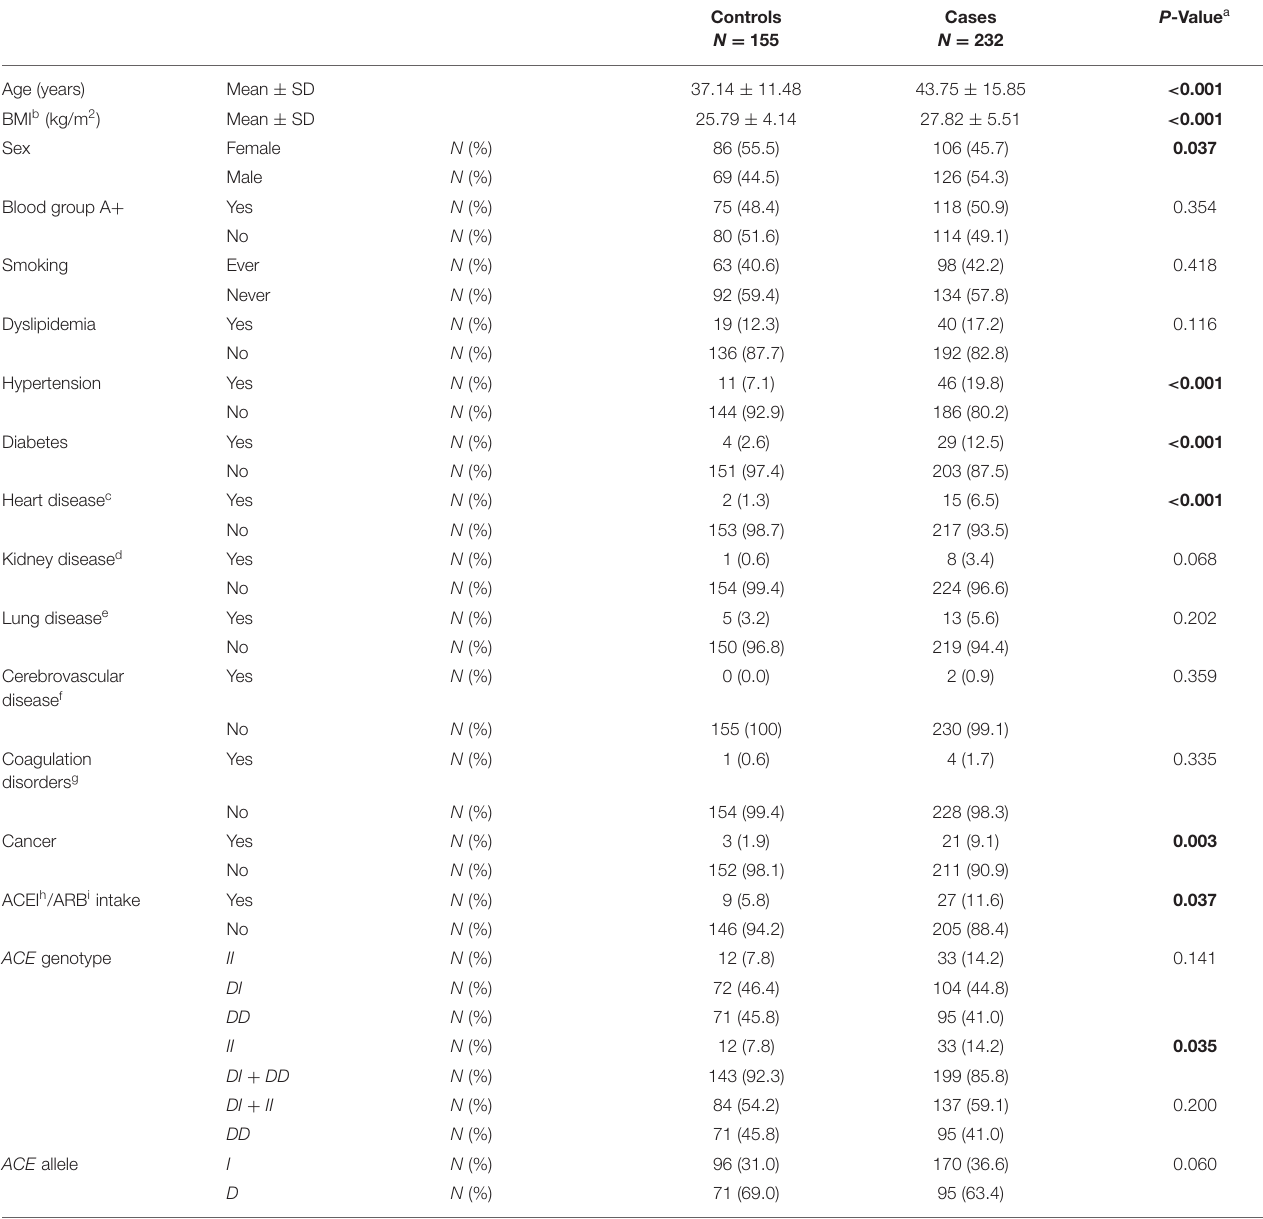
TABLE 1 | Association between baseline characteristics and ACE1 polymorphism in COVID-19 positive cases vs. COVID-19 negative controls.